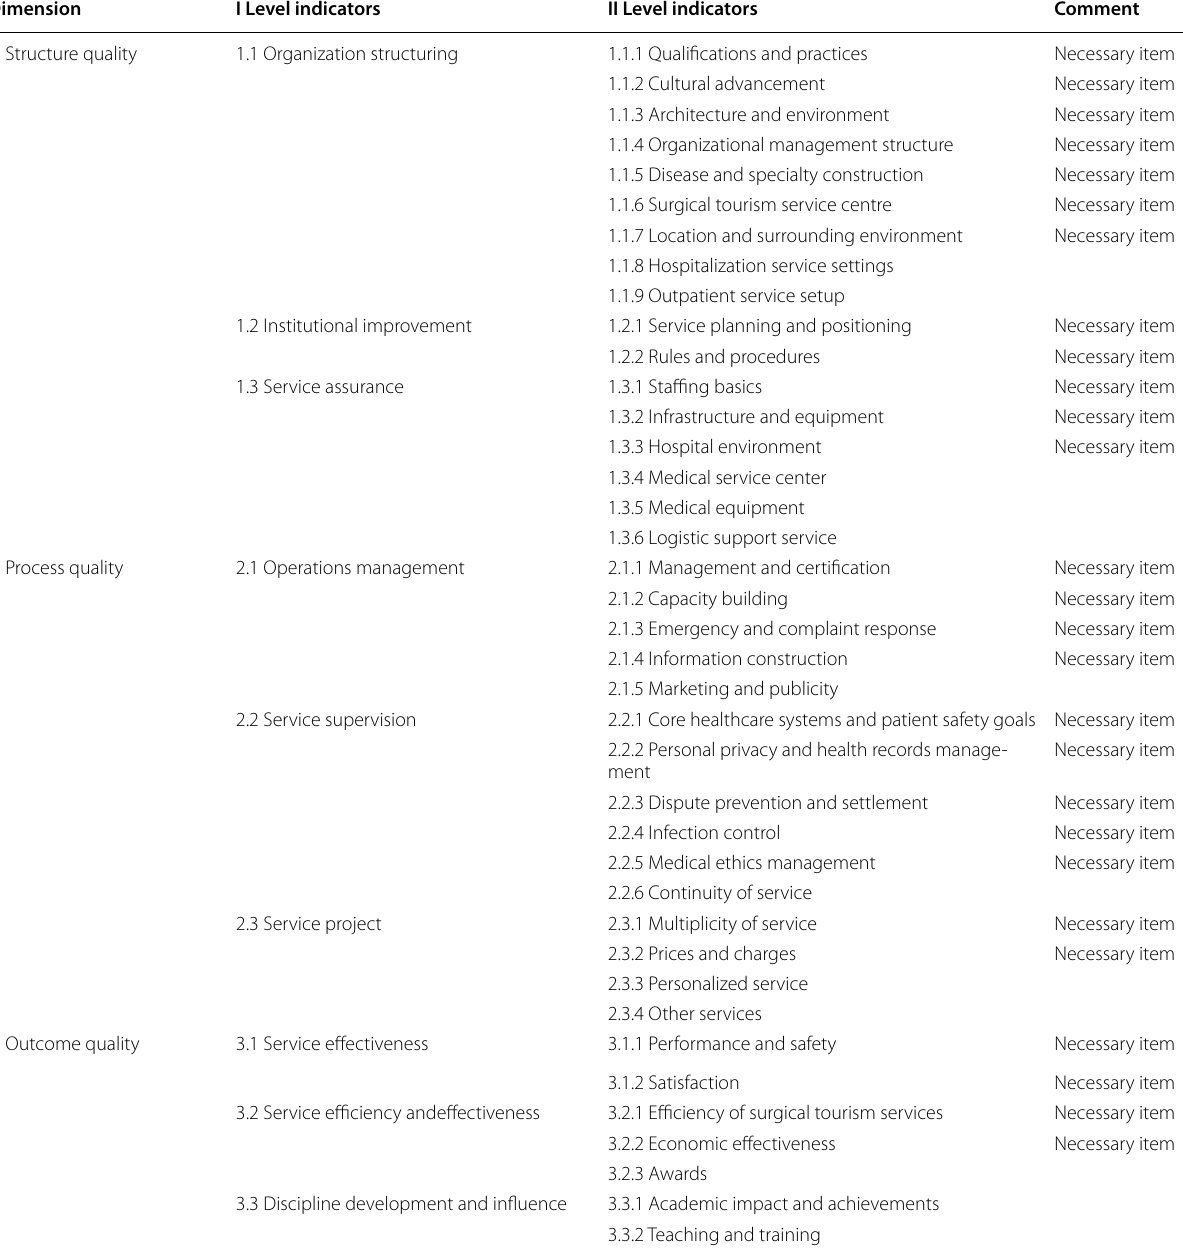
Table 2 Evaluation indicators system of surgical tourism service organizations Dimension I Level indicators II Level indicators